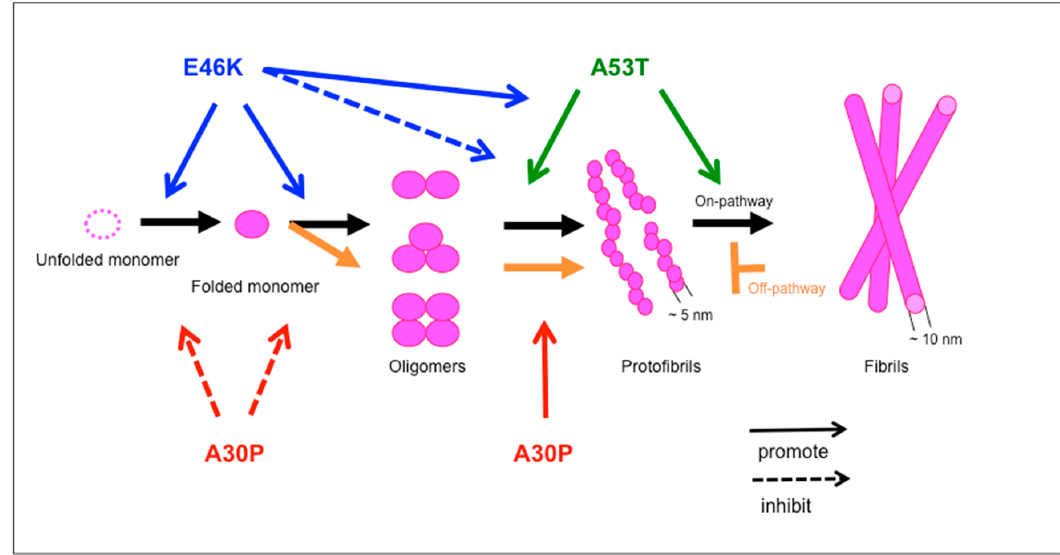
Figure 2. α S mutants, including E46K, A53T, and A30P influence some stages of α S